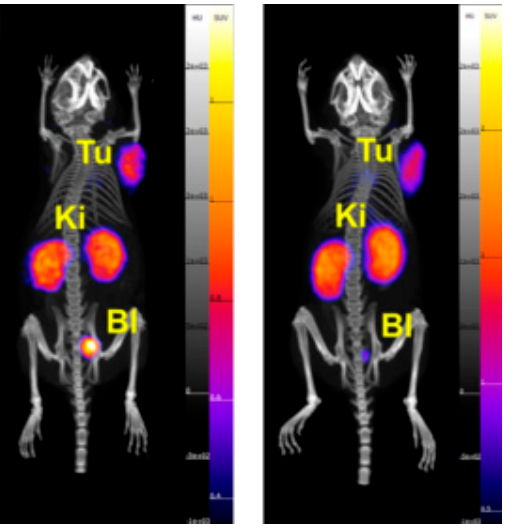
Figure 4. Blood radioactivity values for [ 55 Co]Co-cm10 and [ 55 Co]Co-rf42 in KB-tumor bearing mice at 2 h, 4 h and 24 h post-injection.